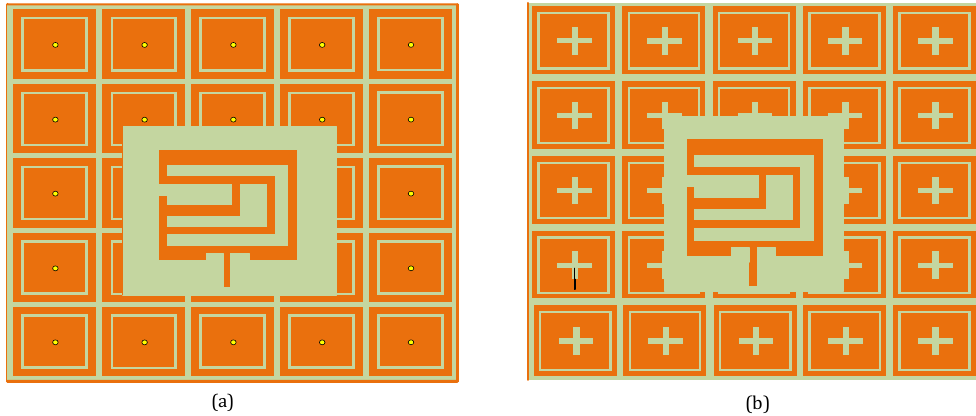
Figure 6. Antenna over EBG ground planes. ( a ) Mushroom-like EBG; ( b ) EBG with plus-shaped slots.